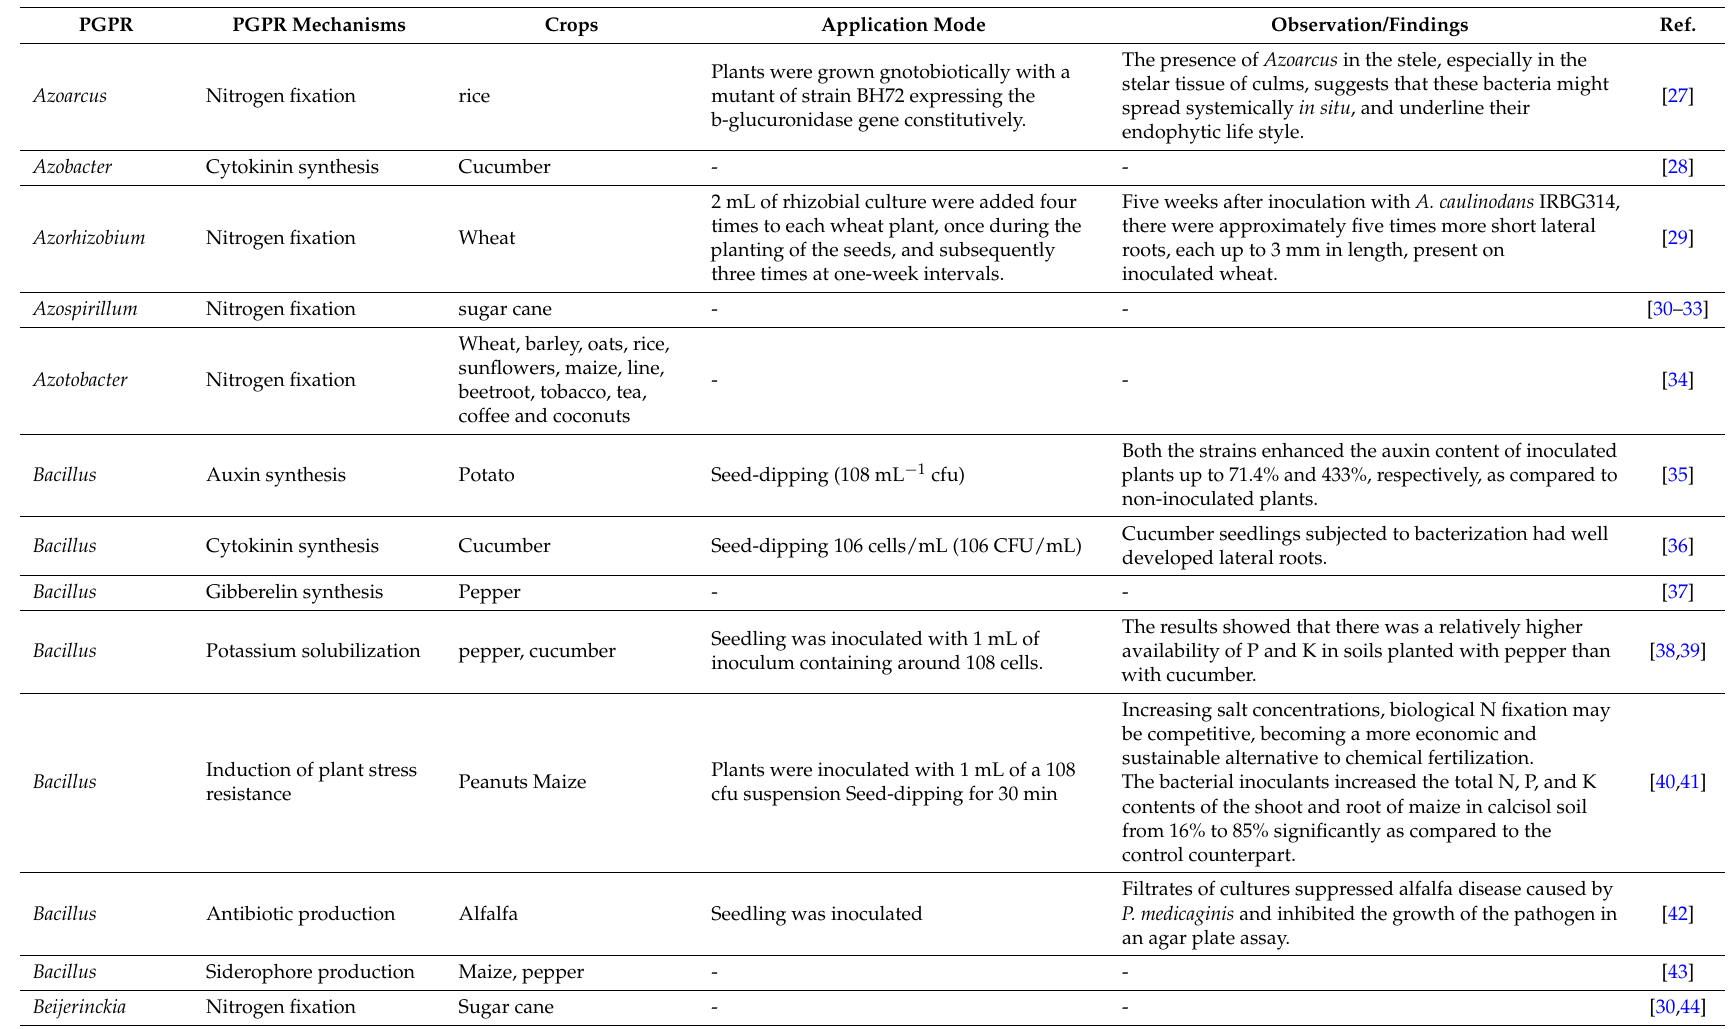
Table 1. List of plant growth promotion